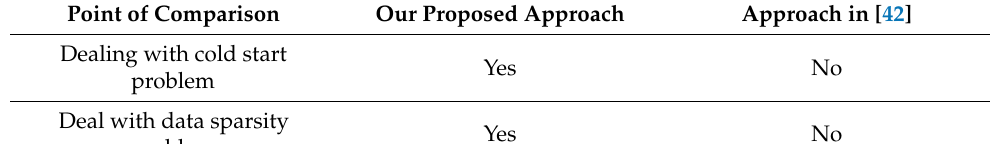
Table 13. Comparison between our proposed approach and the approach presented in [42]. Point of